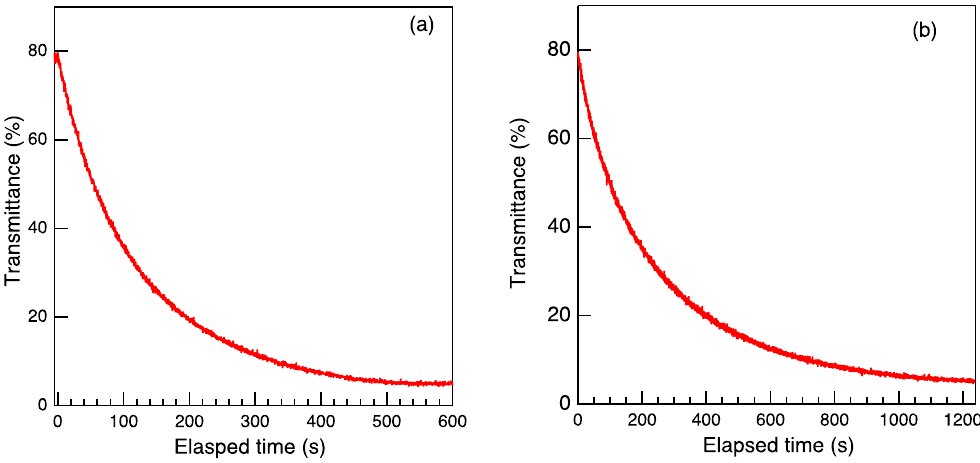
Figure 7. Transmittance decay curves after switching off the applied voltage at 1.2 V vs. Ag/Ag + at the bleached (oxidized) to colored states at ( a ) closed- and ( b ) open-circuit conditions of polyFe/LIIm composite-3/1 film spin coated on ITO glass (1.5 × 1.5 cm) in the three-electrode system with a spring-type Pt wire as a counter electrode and Ag/Ag + as a reference electrode in 0.1 M LiClO 4 of anhydrous acetonitrile solution as an electrolyte solution.